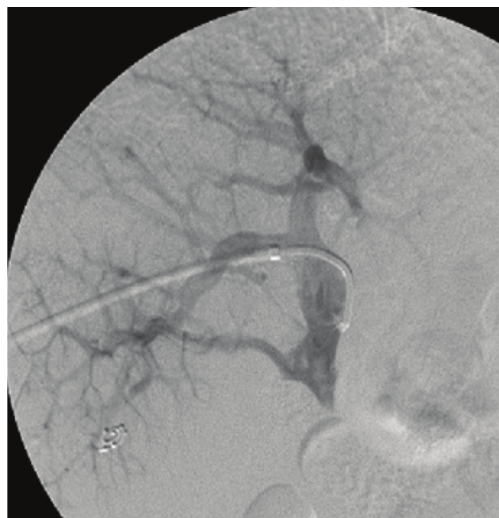
Figure 2: Initial portography revealed completely occluded main portal vein with PVAS and esophageal and gastric varices.